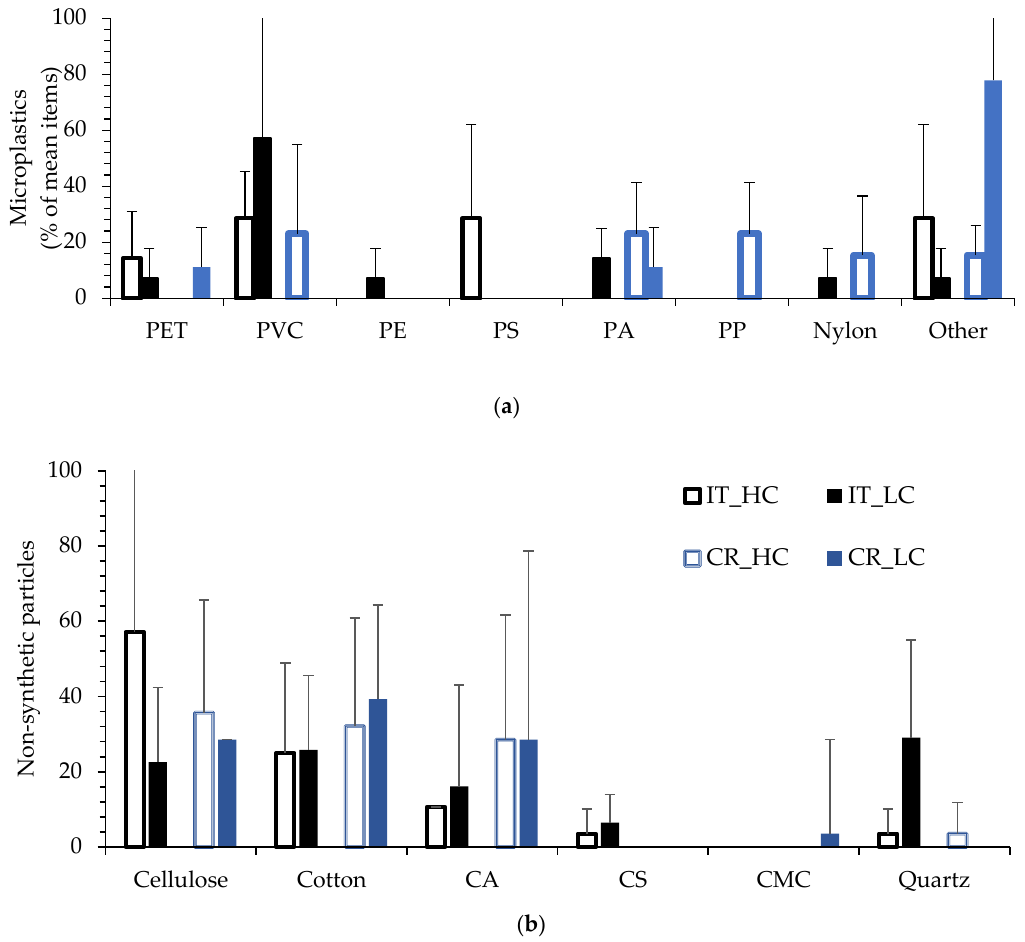
Figure 2. Chemical composition of recovered items in tested table salts of marine origin. ( a ) Microplastic items; ( b ) Non-synthetic particles. Data are grouped per Nation (Italian, black; Croatian, blue) and trademark costs (HC, empty; LC, full). Values are reported as percentages of mean items recorded ( + standard deviation). In ( b ) non-synthetic particles (10–150 µ m) are represented as percentages calculated on mean levels ( + SD). Data evidenced the absence of significant di ff erences ( t -test, p > 0.05) concerning cotton and natural cellulose levels in tested salts. Lower levels of CA in Italian salts compared to Croatian are recorded even if, also in this case, t -test resulted not significant. On the contrary, impurities such as quartz resulted higher in LC Italian salts compare to others salt